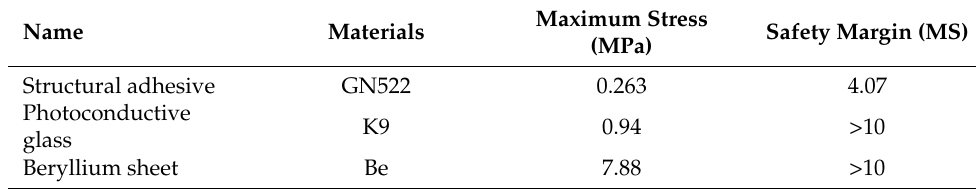
Figure 8. Mathematical model of structural adhesive shear stress: ( a ) column coordinate system; and ( b ) schematic diagram of shear stress in column coordinate system. Table 5. Overload analysis results.